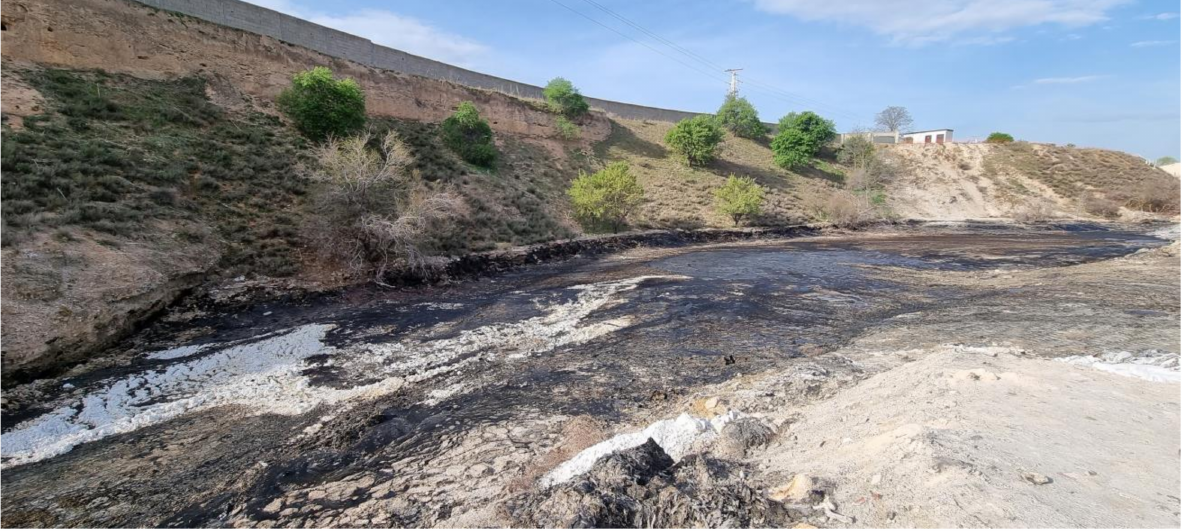
Figure 2. Laguna Sureste. Solid hydrocarbon waste.